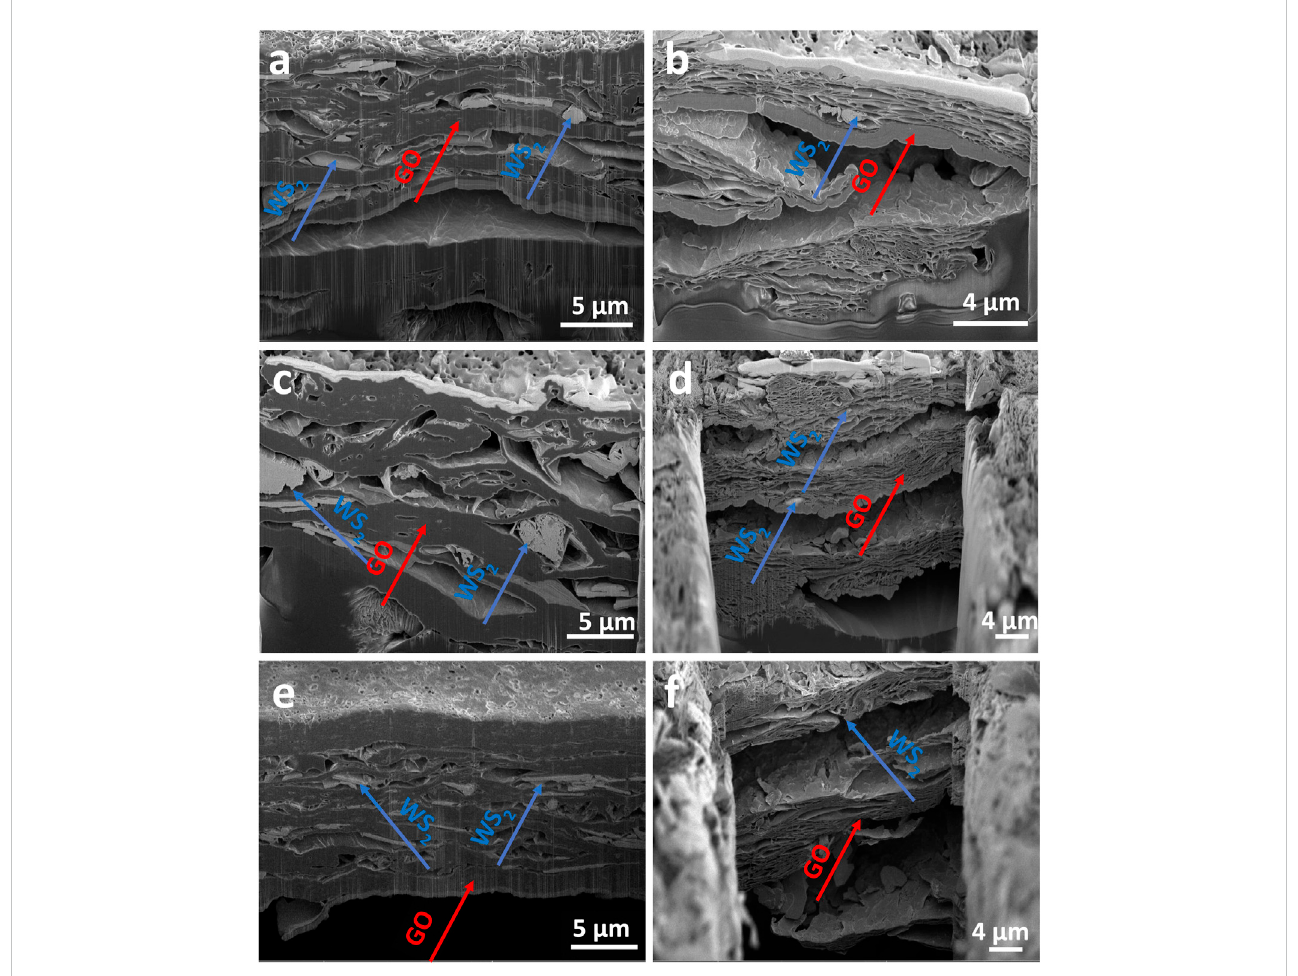
FIGURE 2 SEM images of WS 2 /userGO1 (A) before and (B) after the USER reaction; WS 2 /userGO2 (C) before and (D) after the USER reaction, and WS 2 /userGO3 (E) before and (F) after the USER